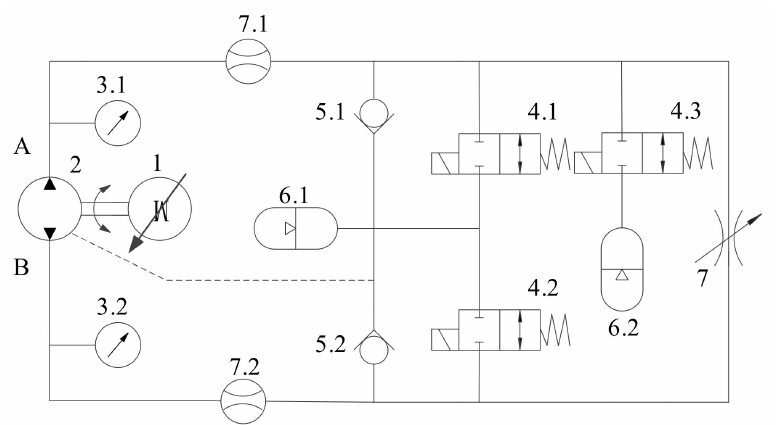
Figure 18. Schematic of accumulator experiment exploration. 1—servo motor; 2—fixed-displacement pump; 3.1/3.2—pressure gage; 4.1/4.2/4.3—magnetic exchange valve; 5.1/5.2—one-way valve; 6.1/6.2—accumulator; 7—throttling valve; 7.1/7.2—flow